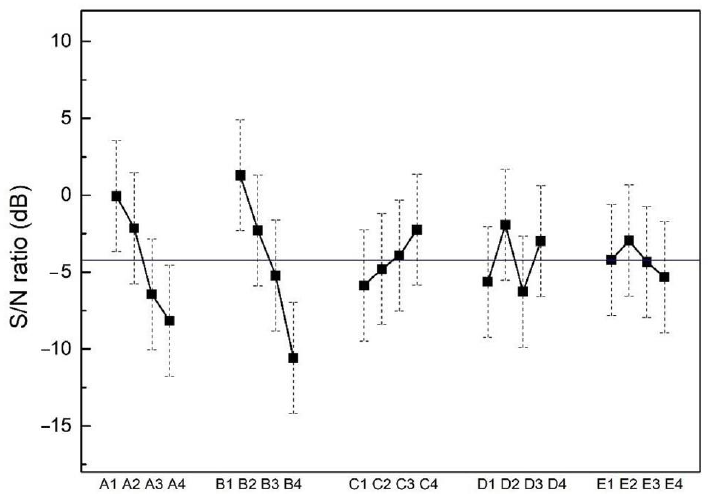
Figure 9. SPM surface topographies of some specimens (S16, SH, SE and SR).